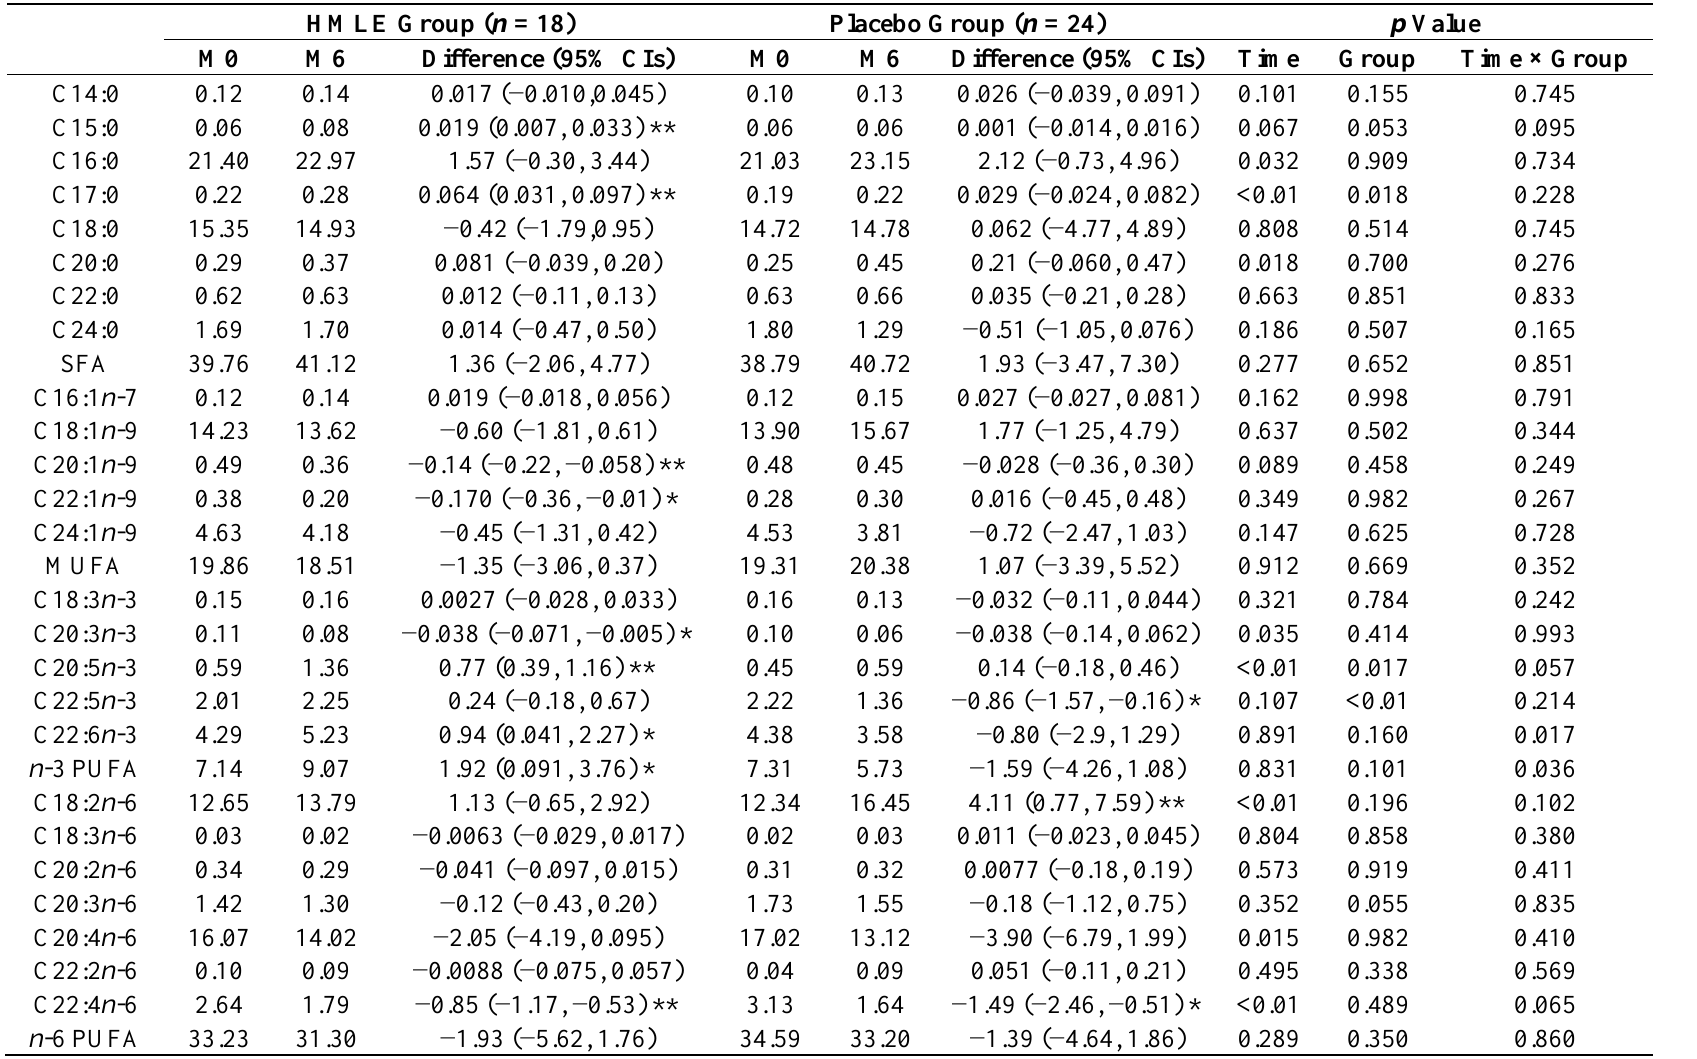
Table 7. Fatty acid composition in erythrocyte membranes (% total fatty acids) of participants before and after intervention. HMLE Group ( n = 18) Placebo Group ( n = 24) p